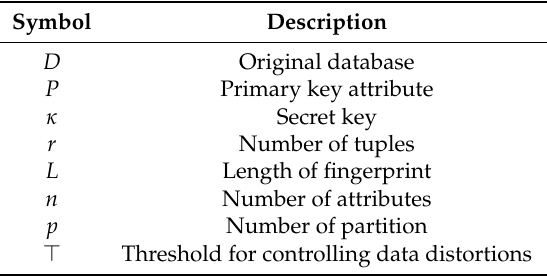
Table 1. Symbols used in the paper.